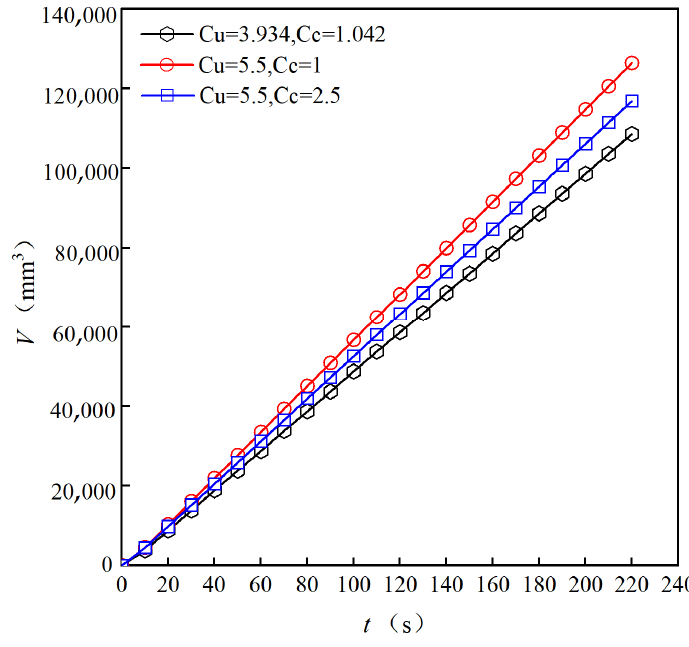
Figure 20. Morphology of the specimen after damage.